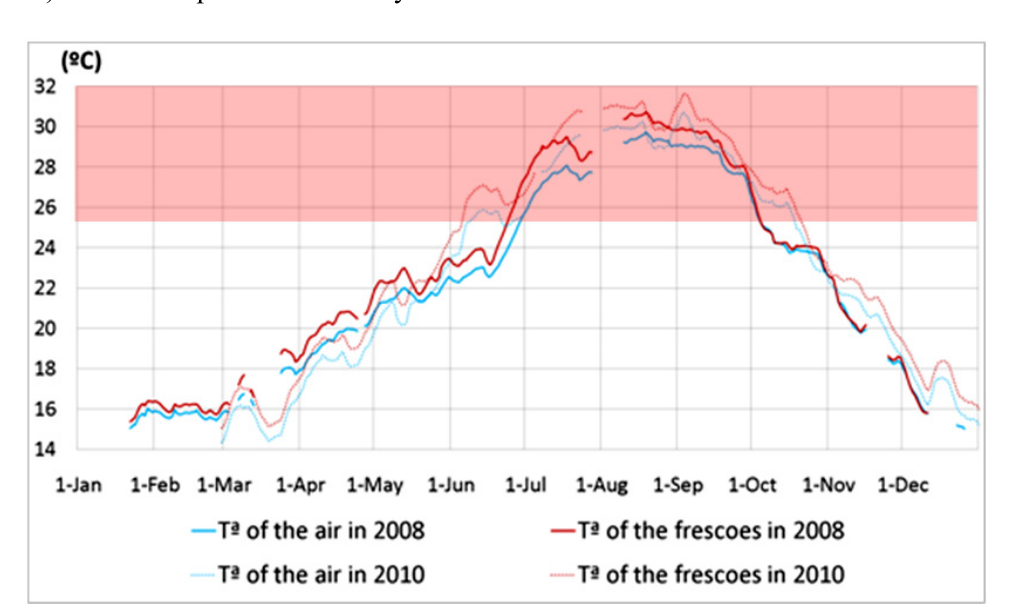
Figure 8. Evolution of Tª data recorded in 2008 (solid lines) and 2010 (dashed lines) by sensors measuring the air (mean of A and B) and temperature of the paintings sensors (see Table 1) that were operative in each